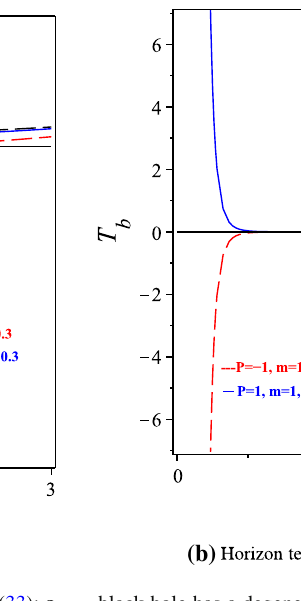
black hole has a degenerate horizon at r dg . Otherwise, m < m min the black hole is naked; b the temperature vanishes on the horizon radius r b . Here we take d =